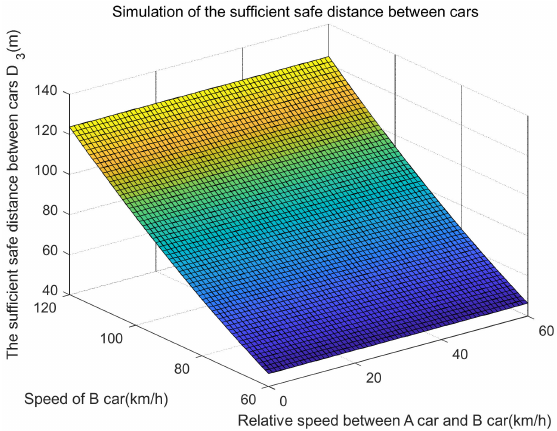
Figure 11. Changes in the sufficient safe distance D 3 with various V B and V r when i = − 0.3 and d =